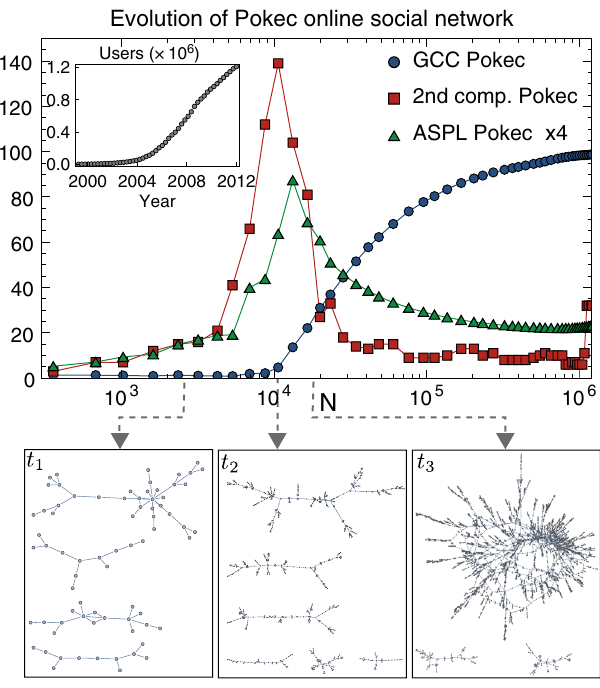
FIG. 1. Topological evolution of the empiric network. Top: The inset shows the evolution of the network size from 1999 to 2012. The main plot shows the relative size of the GCC (blue circles), the size of the second largest component (red squares), and the average shortest path length (green triangles, multiplied by 4 for better readability). Bottom: The largest components of the net- work are visualized at three different times, before the critical point t 1 , at the critical point t 2 , and after it, t 3